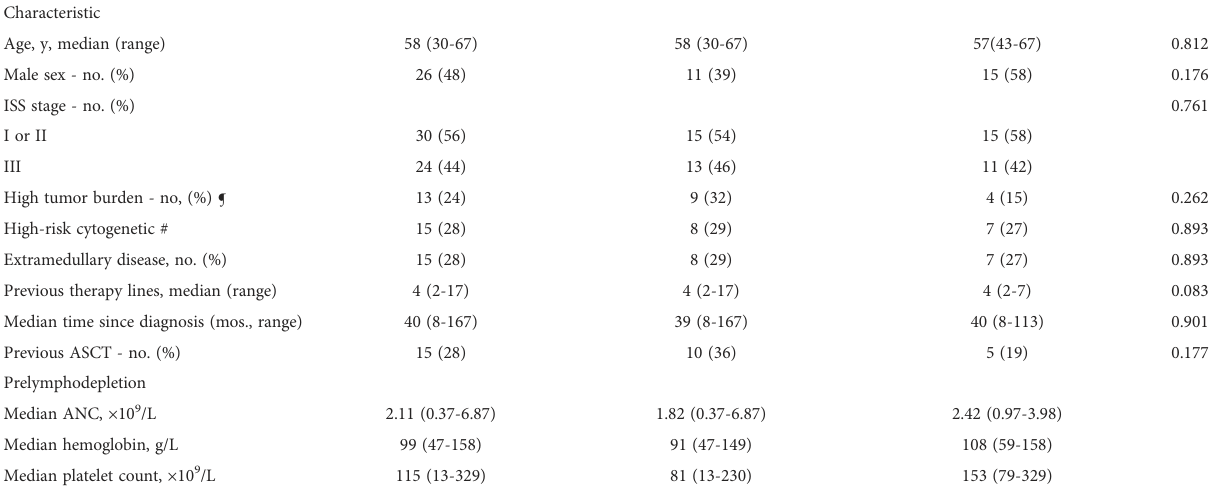
TABLE 1 Demographic and clinical characteristics of the enrolled